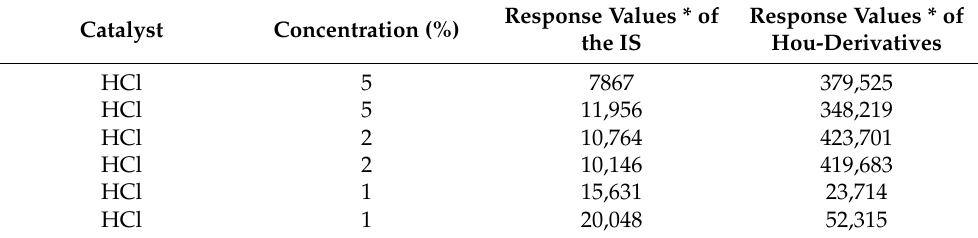
Response Values * of the IS Hou-Derivatives